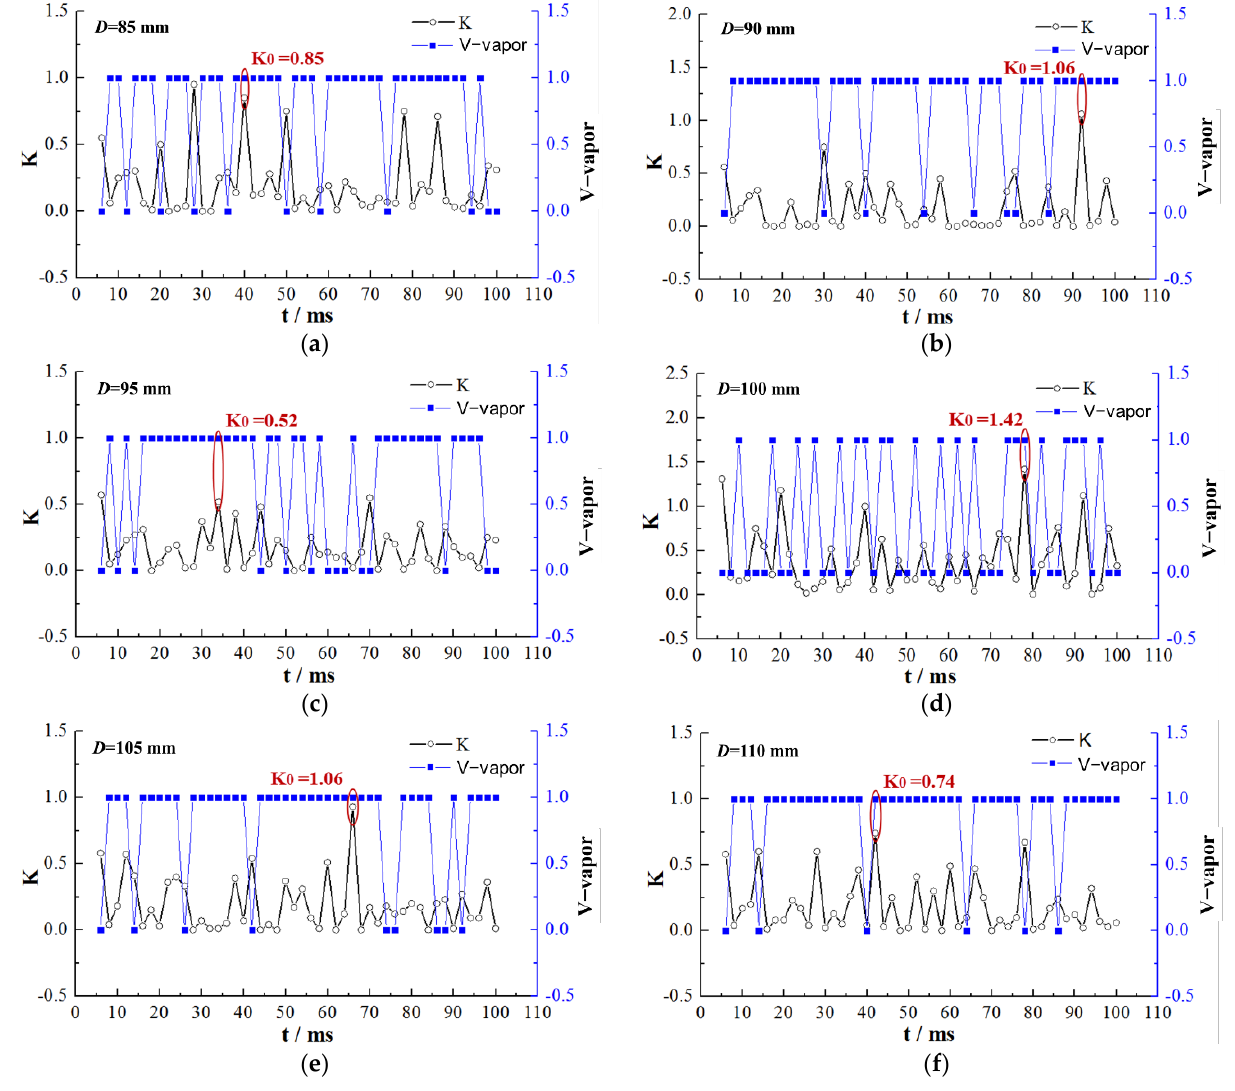
Figure 15. Cavitation numbers with nozzles of different cavity diameter. ( a ) D = 85 mm ( b ) D = 90 mm ( c ) D = 95 mm ( d ) D = 100 mm ( e ) D = 105 mm and ( f ) D = 110